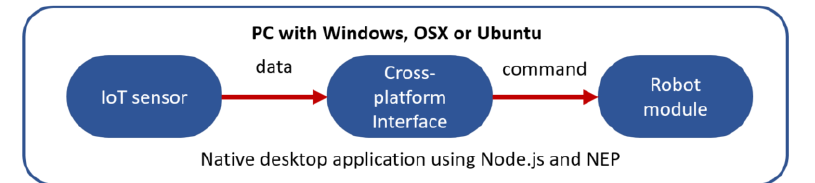
Figure 3. Simple application using Node Primitives (NEP) to connect robot and IoT components in a cross-platform approach. All modules can be executed in the same machine using the Publish/Subscribe pattern; therefore, solving delay issues and improving